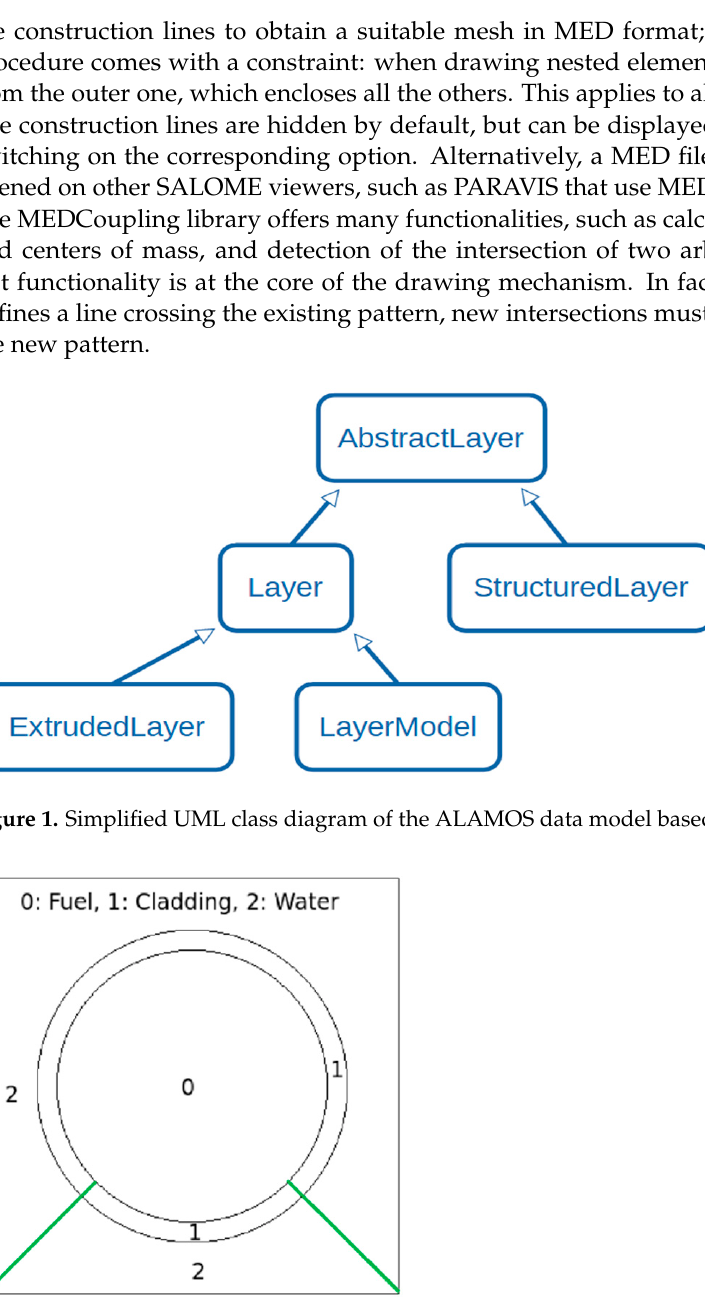
Figure 1. Simplified UML class diagram of the ALAMOS data model based on layers.